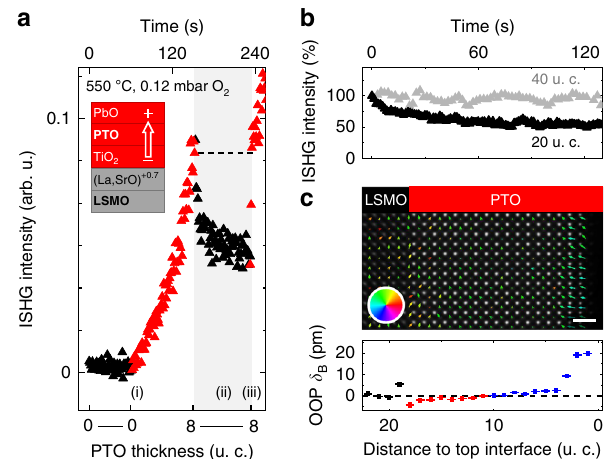
Fig. 1 Polarization suppression from competitive interfaces. a ISHG signal tracking the PTO thin- fi lm polarization during ongoing ( fi lled red symbols, 0 – 8 u. c.) and halted ( fi lled black symbols) growth. The time axis for this growth protocol reveals relaxation of the polarization on the order of 10 2 s. The inset shows the chemistries of interfacial planes at the PTO ∣ LSMO interface and the polarization direction set by the bottom interface. The dashed line indicates recovery of the ISHG intensity upon resuming the deposition. b Time-dependent ISHG signal after interrupting deposition, normalized to the maximum value = 100. c Post-deposition STEM map of the dipole moments. The arrows show the direction (color wheel) and amplitude (arrow length) of the associated dipole moments (top). Scale bar is 1 nm. The OOP B-site displacement ( δ B ) of the persistent state is mapped throughout the PTO ∣ LSMO bilayer (bottom). Black symbols refer to LSMO, red and blue symbols refer to upwards and downwards polarization, respectively, in PTO. The error bars are the standard error of the mean. The electrostatic boundary conditions at the La 0.7 Sr 0.3 O ∣ TiO 2 -terminated LSMO ∣ PTO interface result in the observed displacement discontinuity, see main text and ref. 16